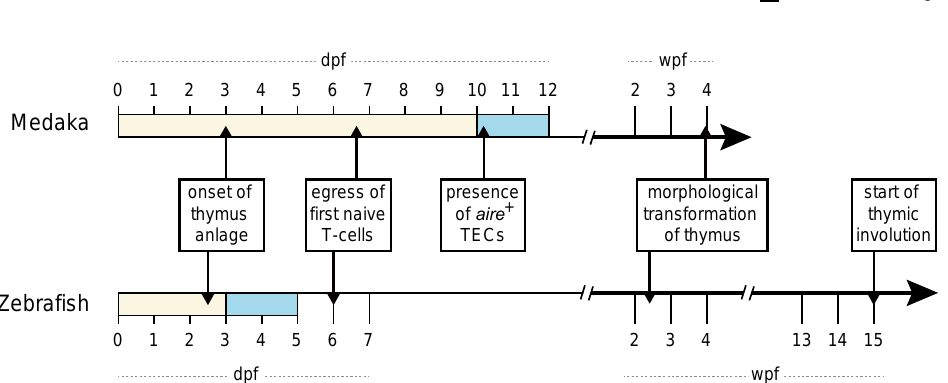
Figure 1. Comparative timeline of medaka and zebrafish T-cell and thymic development. The onset of thymus anlage was defined by the expression of foxn1 , as shown previously [31,32]. The time window for the egress of first naïve T-cells into the periphery was determined using live in vivo imaging in medaka [43] and zebrafish [31]. The expression of autoimmune regulator ( aire ) gene, a marker for medullary TECs have been described in medaka yolksac larvae [43] but not yet in zebrafish. Note that medaka possesses a fully functional thymus with T-cells in the periphery shortly before hatching around 10 days post-fertilization (dpf) [43]. At later stages, the thymus undergoes a morphological transformation, which occurs in zebrafish between 2- and 3-wpf [39] and in medaka at 4 wpf [48]. Based on histological studies, the age-related thymic regression is prominent in zebrafish at 15 wpf [39]. In medaka, however, the starting point of thymus involution is not clear. Based on one study, the thymic regression in medaka continues until five years of age [48].